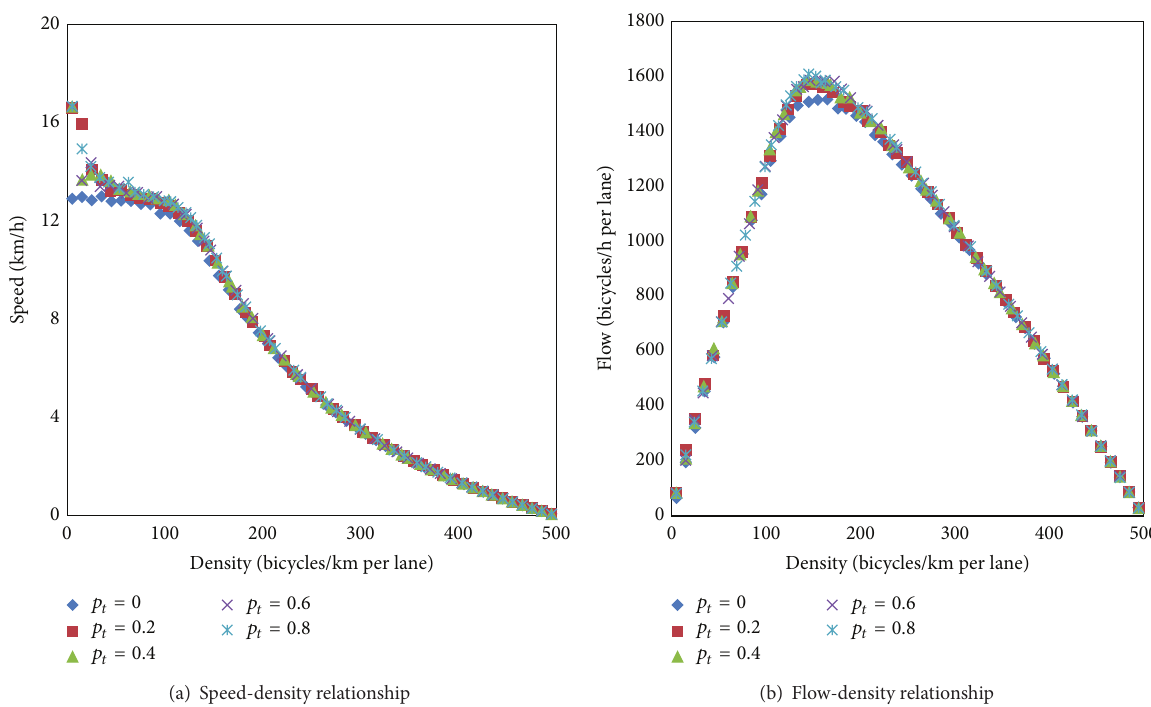
Figure 2: Speed-density and flow-density relationships under different lane-changing probabilities when 𝑝 𝑑 = 0.2 and 𝑝 𝑒 =